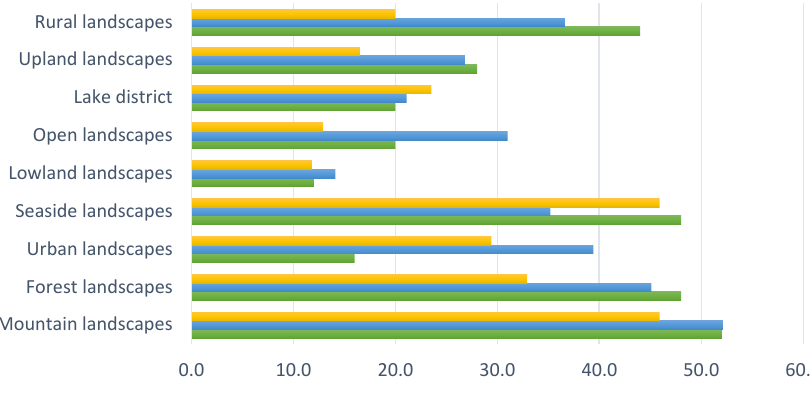
Figure 3. Landscape preferences among surveyed students (%). Among all surveyed student groups, mountain and forest landscapes were the most frequently chosen landscapes. Lowland landscapes, on the other hand, were chosen the least frequently. Urban landscape was indicated more often by tourism and recreation students and spatial management students than by geography and other fields of study students (Figure 4).